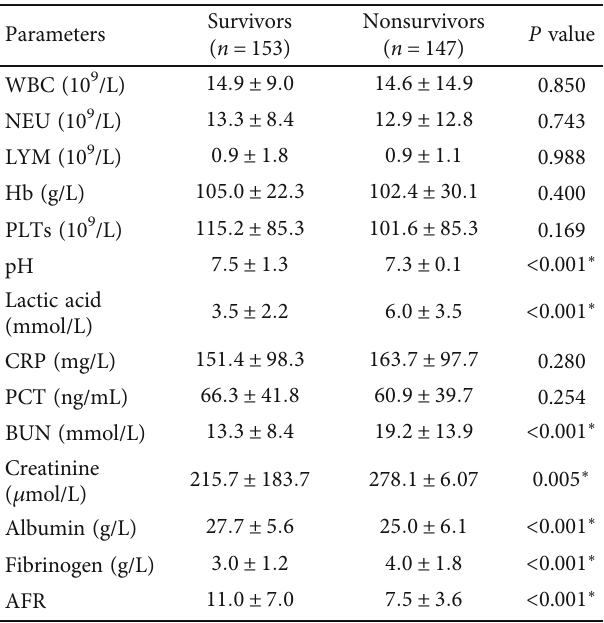
Table 2: Laboratory variables of patients with sepsis between the survivor and nonsurvivor